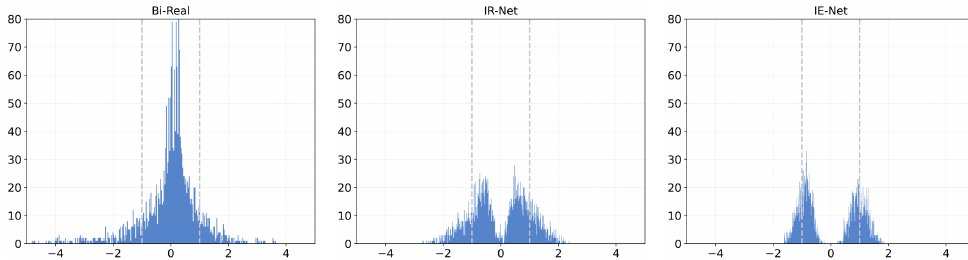
Figure 4. Weight distributions (before binarization) of the Bi-Real, IR-Net, and IE-Net in layer1.0.conv1 of binary ResNet-20. The weights in Bi-Real are gathered around zero value, which is far from the binary values +1 and − 1, leading to large quantization error. The IR-Net alleviates this problem while there are still a relatively large number of weights existing around zero. The IE-Net proposes the IEE to shape the two distributions around +1 and − 1, which enhances the information of binary weights by reducing the quantization